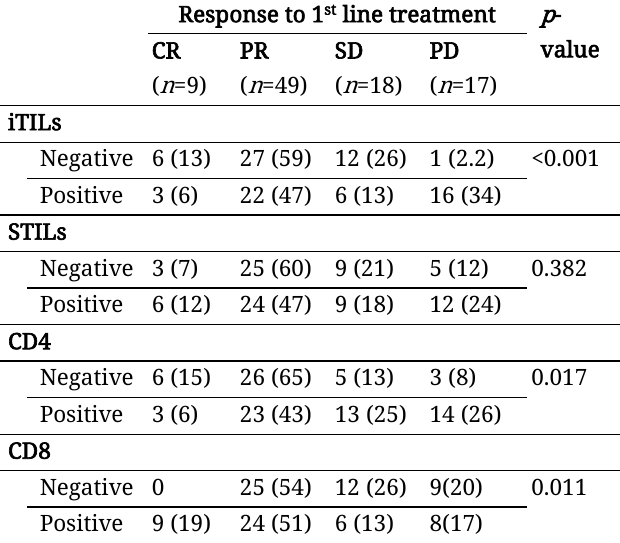
Table 4: Relationship between iTILs, sTILs, CD4, and CD8 and the best response to 1 st line treatment of metastatic